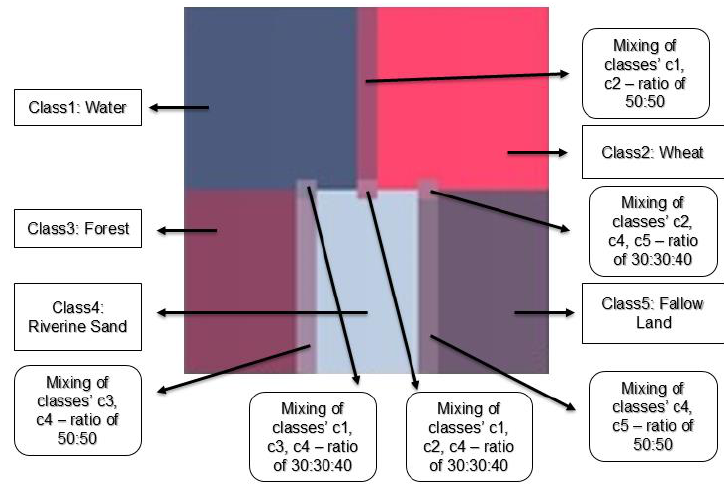
Figure 4. Details of simulated images.